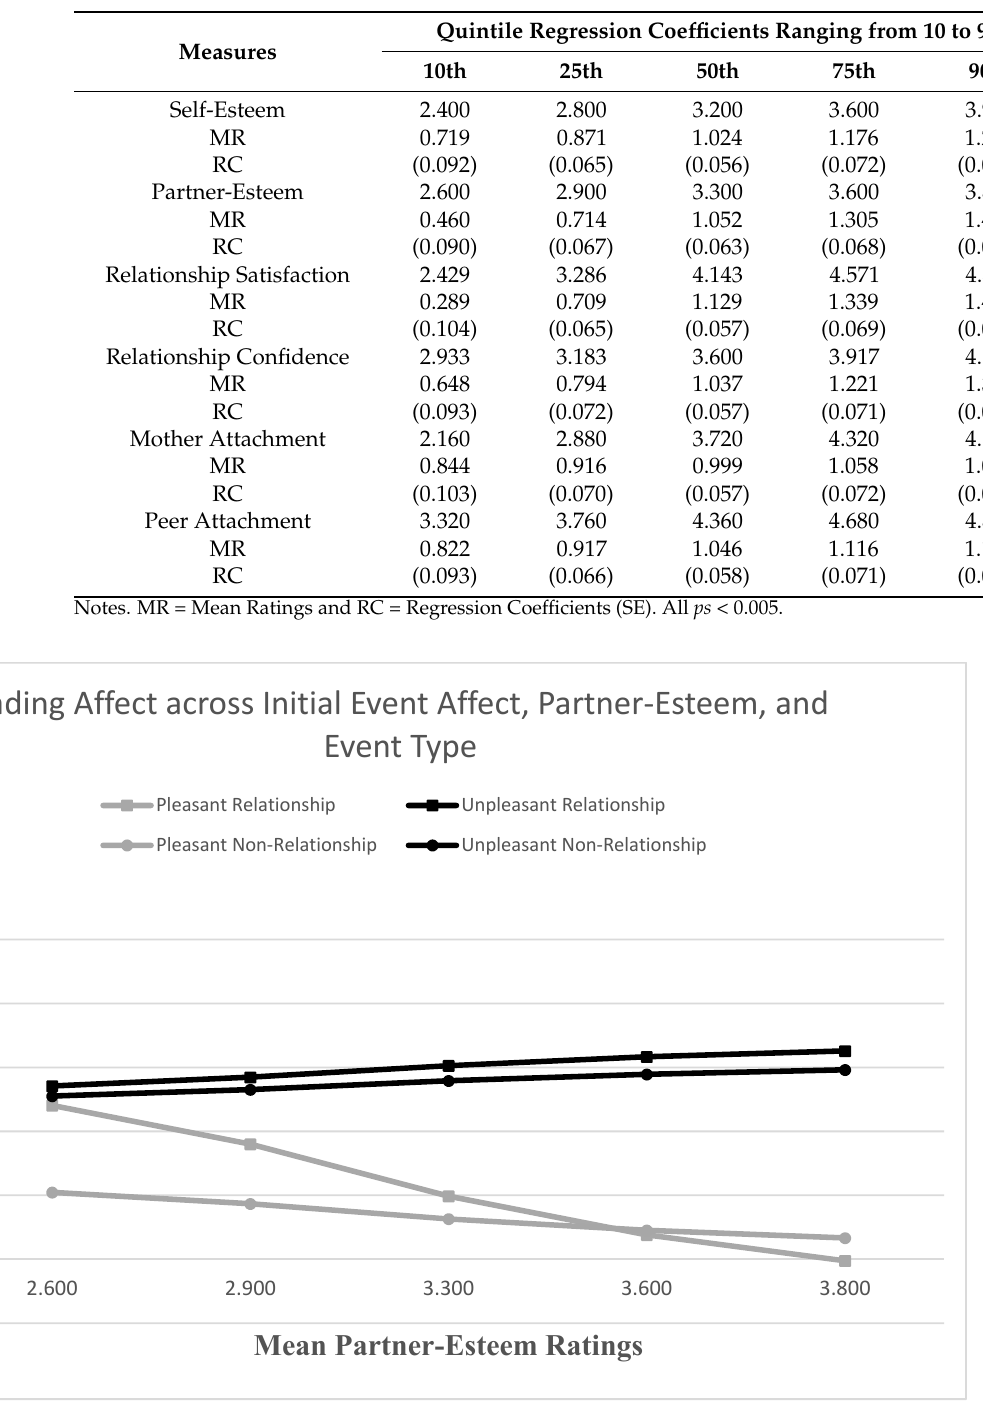
Table 1. Fading Affect Bias (FAB) Regression Coefficients (SE) across Quintiles of Self-Esteem, Partner-Esteem, Relationship Satisfaction, Relationship Confidence, Mother Attachment, and Peer Attachment Ratings (large positive coefficients represent large FAB).